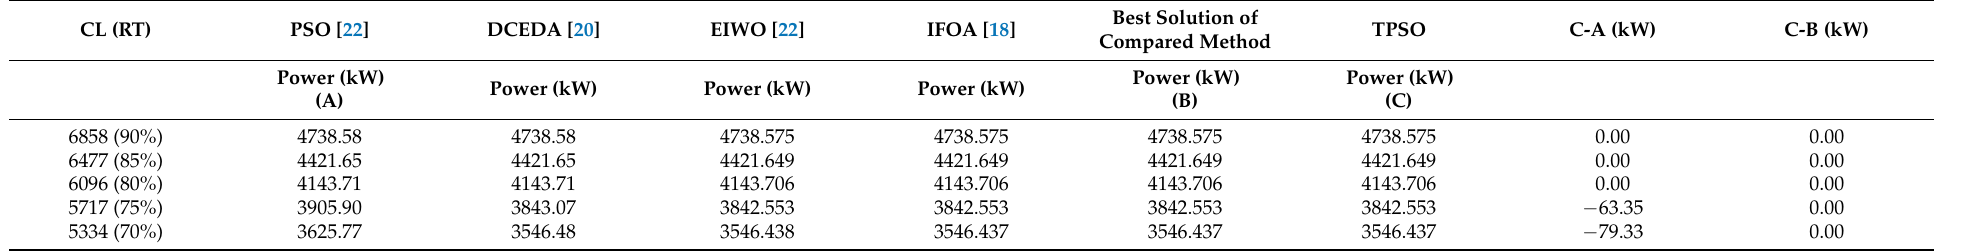
Table 13. Comparison of optimum value operated by TPSO, PSO, DCEDA, EIWO, IFOA in Case 1.